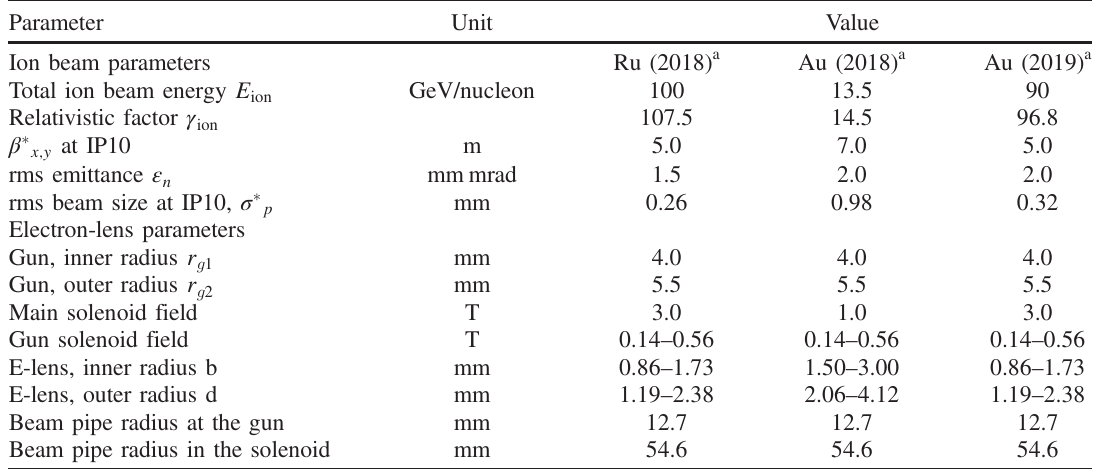
TABLE I. Main electron and ion beam parameters for the RHIC hollow lens experiments.